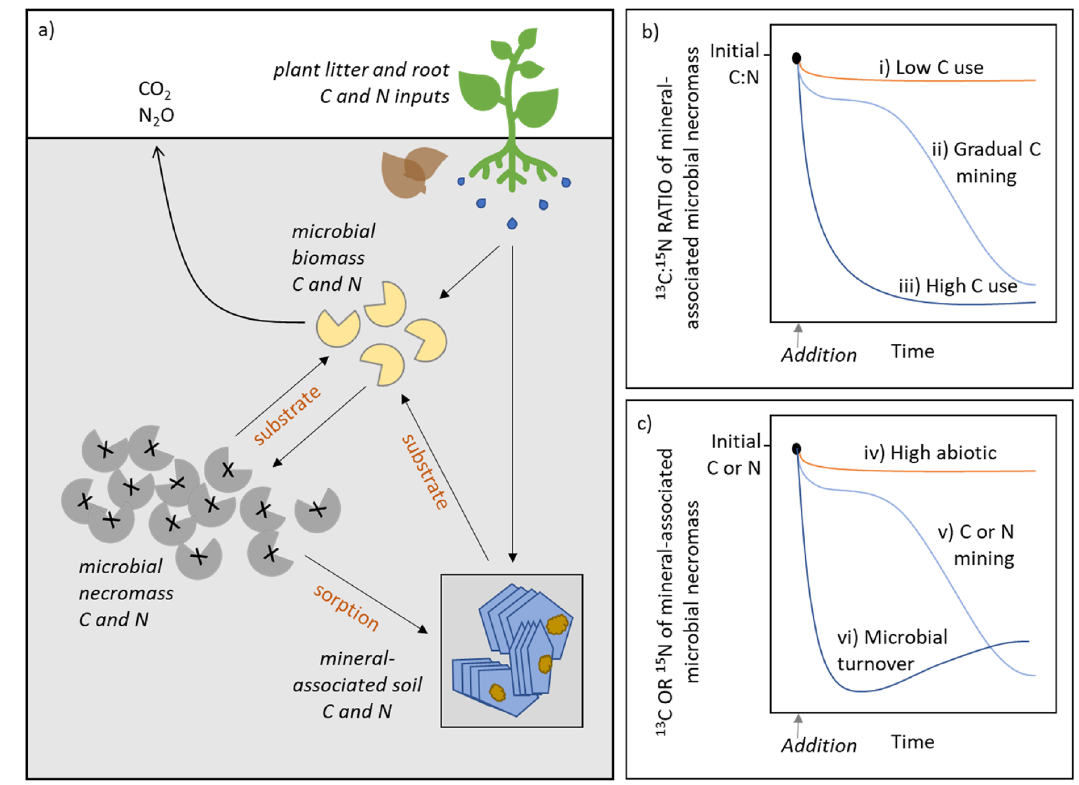
Fig. 1 The fate of microbial necromass in soil, and the hypothetical response curves for stable-isotope tracing of mineral-associated microbial necromass in soil as a tool to assess that fate. a A representation of how plant carbon inputs to soil may directly adsorb to fi ne minerals, or be consumed by microbial biomass then become necromass. Here we quantify how necromass may be recycled by microbial biomass as substrate, sorbed to fi ne minerals, and then mined from mineral surfaces by soil microbes. b We traced isotopically-labelled microbial necromass to sorption on fi ne minerals and used the 13 C: 15 N ratio of the mineral-associated necromass to indicate sustained low use of necromass-C as microbial substrate and high sustained C mineral-association (i), or gradual microbial C-limitation and C-mining of mineral-associated necromass-C pools (ii), or rapid use of necromass-C as microbial substrate with no microbial mining (iii). c We assessed the 13 C or 15 N of the mineral-associated necromass to indicate if rapid abiotic interaction of necromass on fi ne minerals was high as hypothesized (iv) or initially low (vi), and if this initial state was followed by loss from microbial mining of C or N (v), versus gradual accumulation of necromass-C or N, for instance as a result of turnover of the biomass that consumed necromass C or N